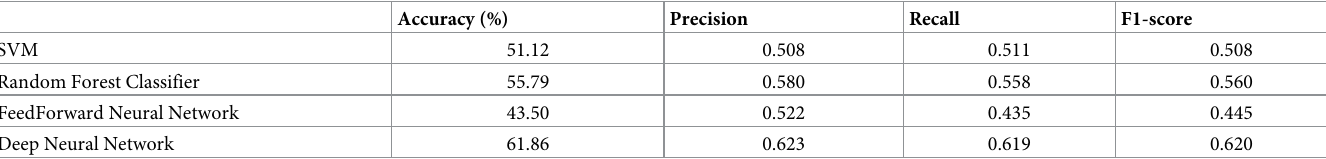
Table 2. Performances for machine learning models using leave-one-out cross